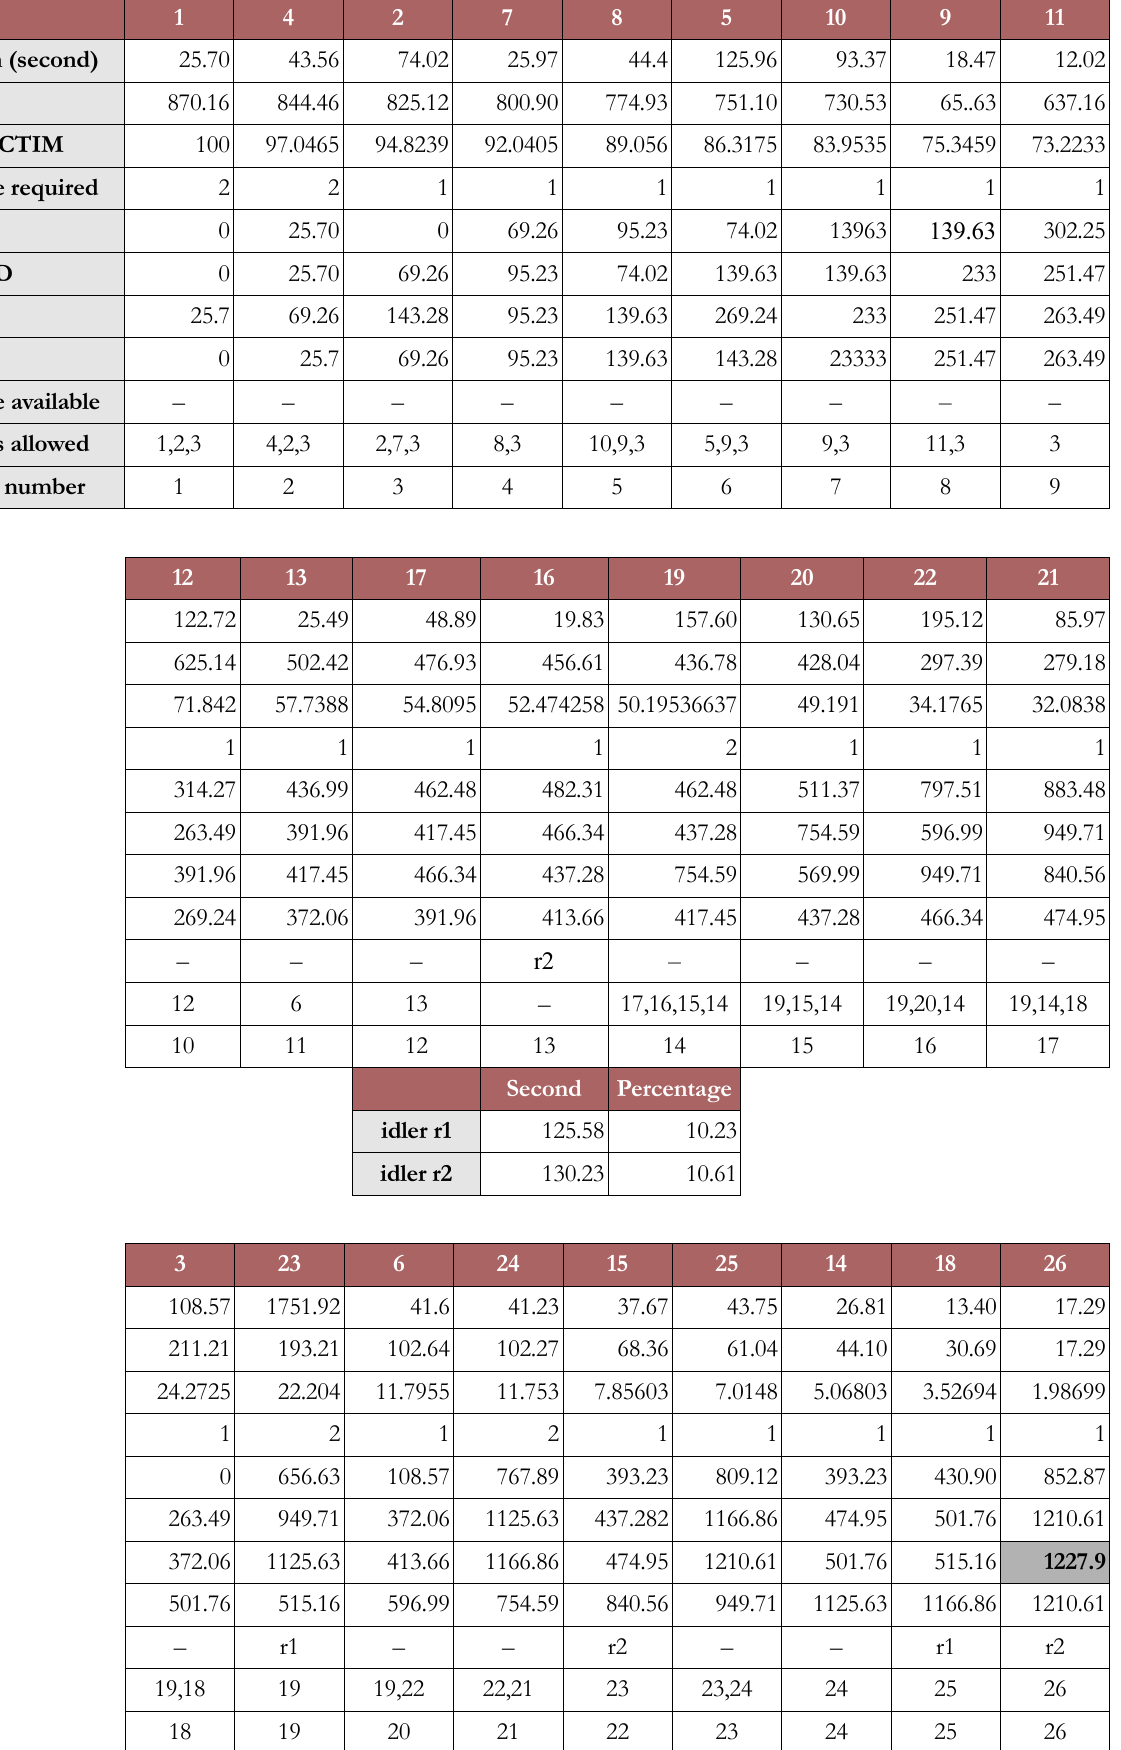
Table 10. ACTIM Scheduling, Rmax = 2, n(r) = 2 (Scenario